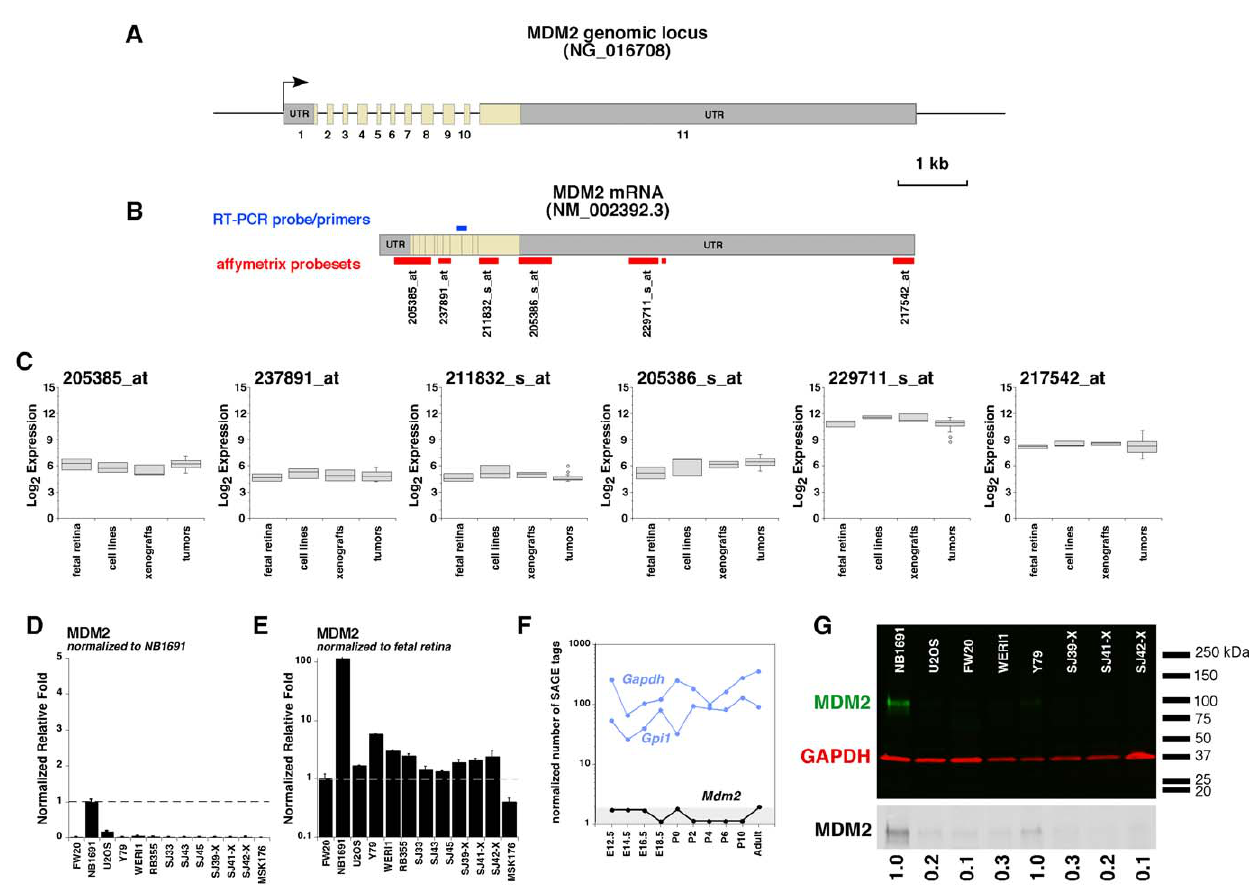
Figure 1. Expression of MDM2 in retinoblastoma. A ) Structure of the genomic organization of the 11 exons of human MDM2 . The exons are to scale as shown, but the introns are not to scale. B ) Schematic of the spliced MDM2 mRNA that produces the full-length MDM2 protein. The location and identification of Affymetrix gene expression array probesets are shown in red and the location of the real time RT-PCR probe/primer set is shown in blue. ( C ) Boxplots of the Log 2 expression of each of the 6 probesets that uniquely mapped to MDM2 for fetal retina, cell lines, xenografts and 52 primary human retinoblastomas. In general, genes expressed below Log 2 of 7–8 cannot be detected by SAGE and are below the limit of reliable detection for retinal samples. ( D ) Real time RT-PCR for MDM2 using Taqman probes as shown in (B) for fetal retina at gestational stage week 20 (FW20), a control (NB1691) that expresses high levels of MDM2, and a control (U2OS) that expresses high levels of MDM4, retinoblastoma cell lines (Y79, Weri1, RB355), primary tumors (SJ33, SJ43, SJ45), and retinoblastoma xenografts (SJ39-X, SJ41-X, SJ42-X and MSK176). Values were normalized to the positive control (NB1691). ( E ) The same data as shown in (D) but normalized to fetal retina. Each bar is the mean and standard deviation of duplicate experiments. ( F ) The SAGE data from developing mouse retina shows Mdm2 is not expressed at significant levels in the developing mouse retina. The gray shaded box represents the limit of detection by SAGE ( , 2 normalized tags per sample). Gapdh and Gpi1 are plotted as ubiquitiously expressed internal controls. ( G ) Immunoblot of MDM2 (green) protein in a subset of the samples analyzed by real time RT-PCR. Gapdh (red) was used as an internal reference for gel loading and the normalized values are presented below the black and white presentation of the blot for MDM2.